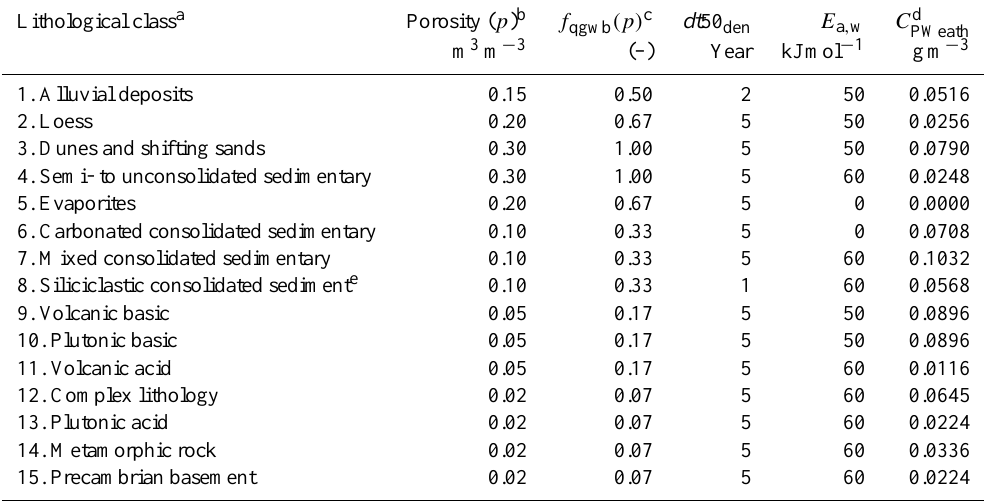
Table 1. Porosity ( p ), the fraction of excess water Q eff flowing to deep groundwater ( f qgwb (p) ), half-life of nitrate in groundwater ( dt 50 den ), activation energy ( E a , w ) and background P concentration ( C PWeath ) for various lithological classes. Lithological class